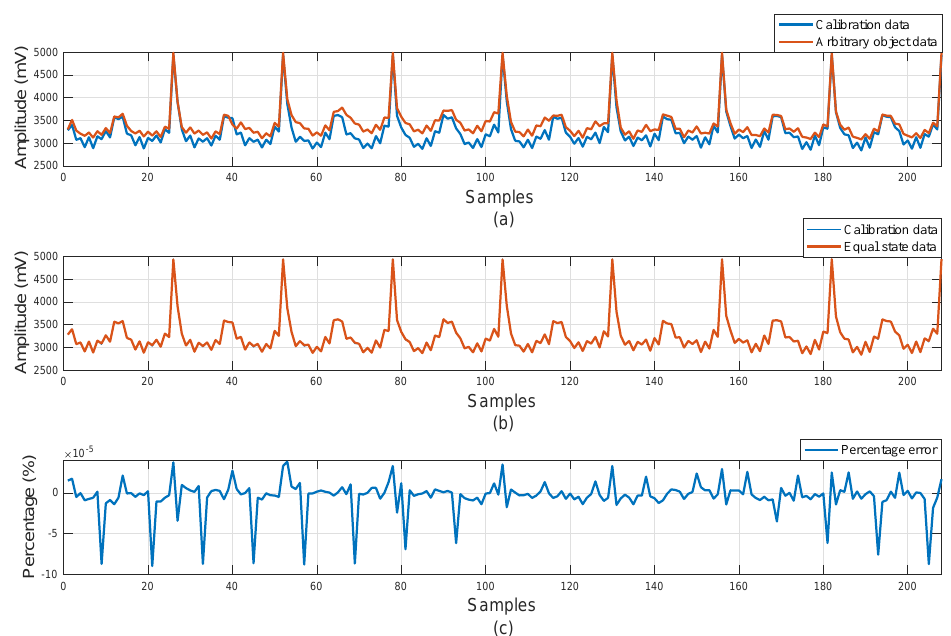
Figure 9. Three graphics of a measurement cycle. ( a ) Comparison between calibration data and arbitrary object data, ( b ) Calibration data and second round of calibration-plane measurements, and ( c ) Percentage of error between calibration data and the second round of measurements.